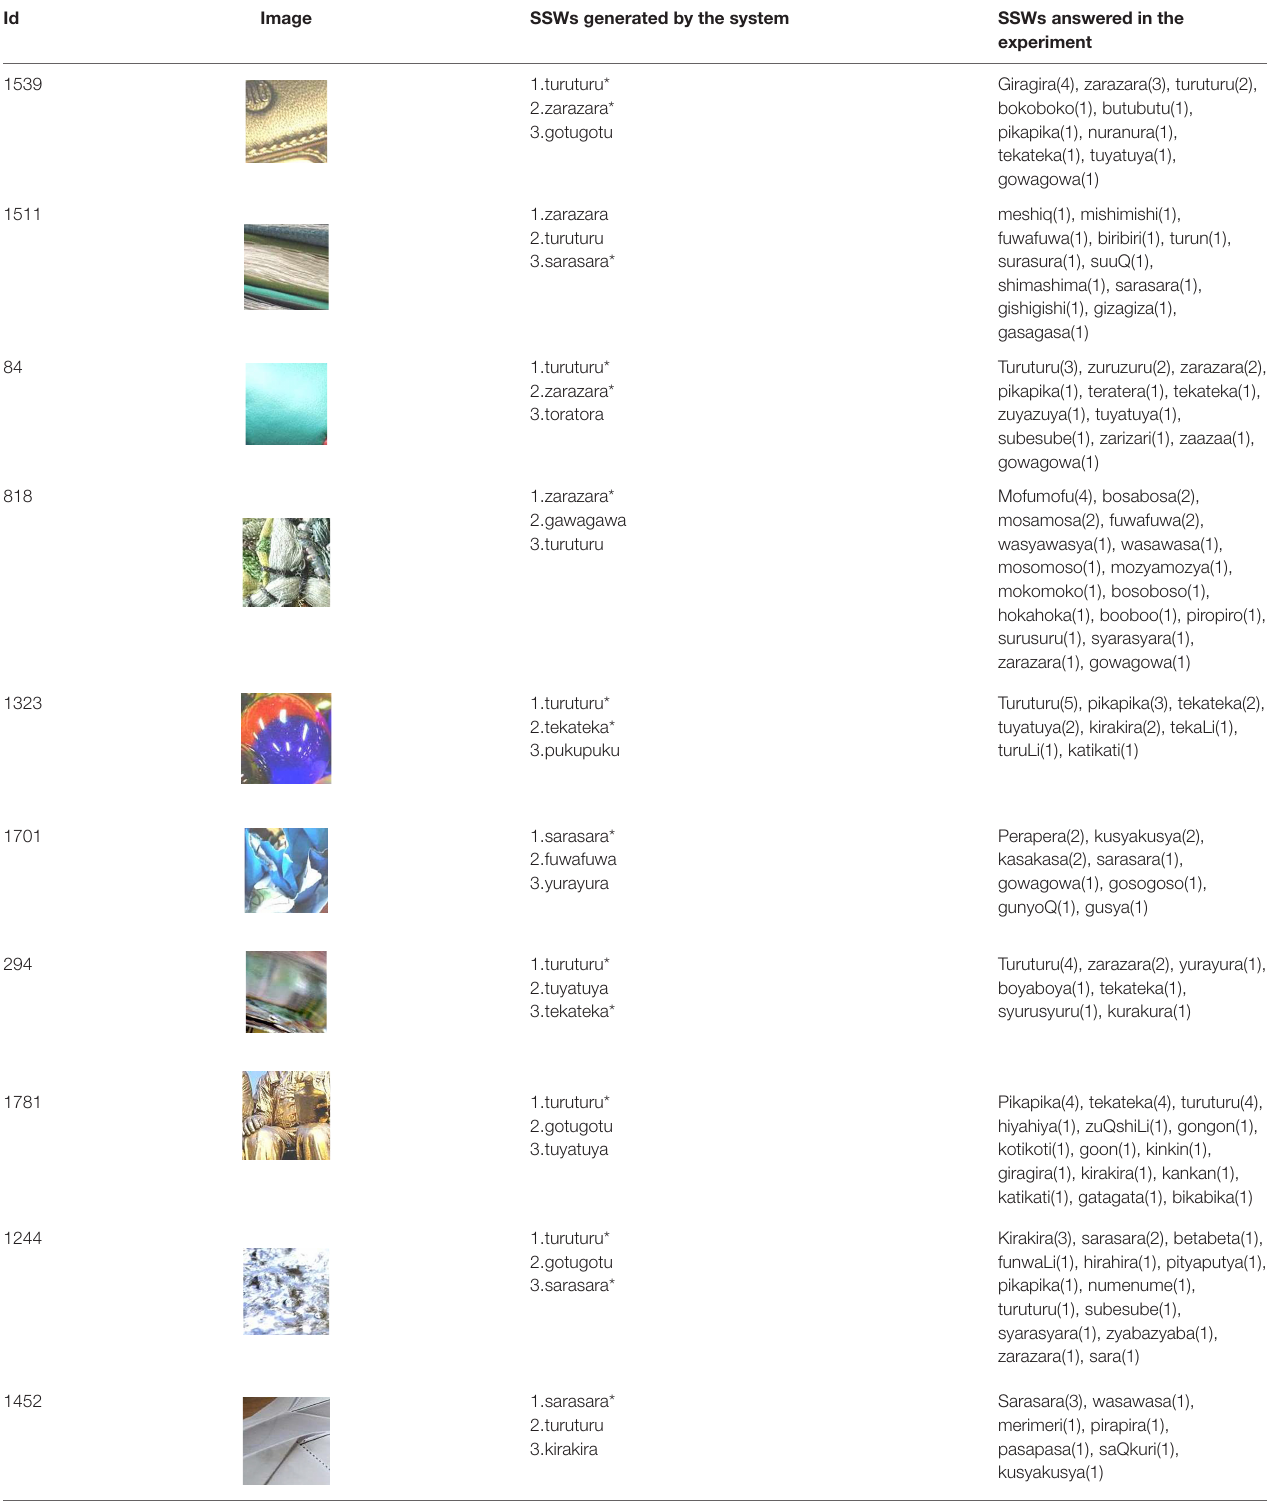
TABLE 4 | SSWs generated by the system for some images that is not used for the learning.